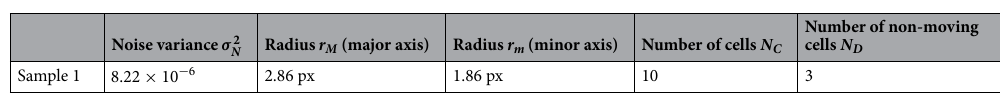
Table 5. Simulation parameters for segmentation and localization